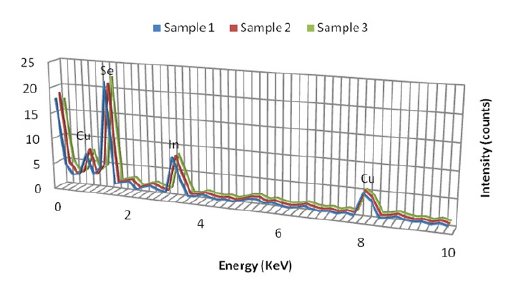
Figure 9. EDAX pattern of CuInSe 2 films